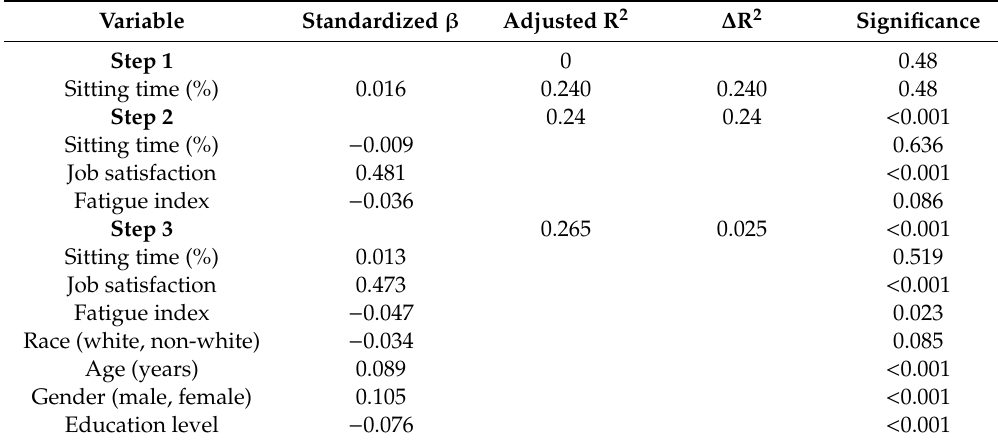
Table 4. Associations between percent time spent sitting during a typical workday and productivity, statistically adjusting for job satisfaction, fatigue index, and demographic